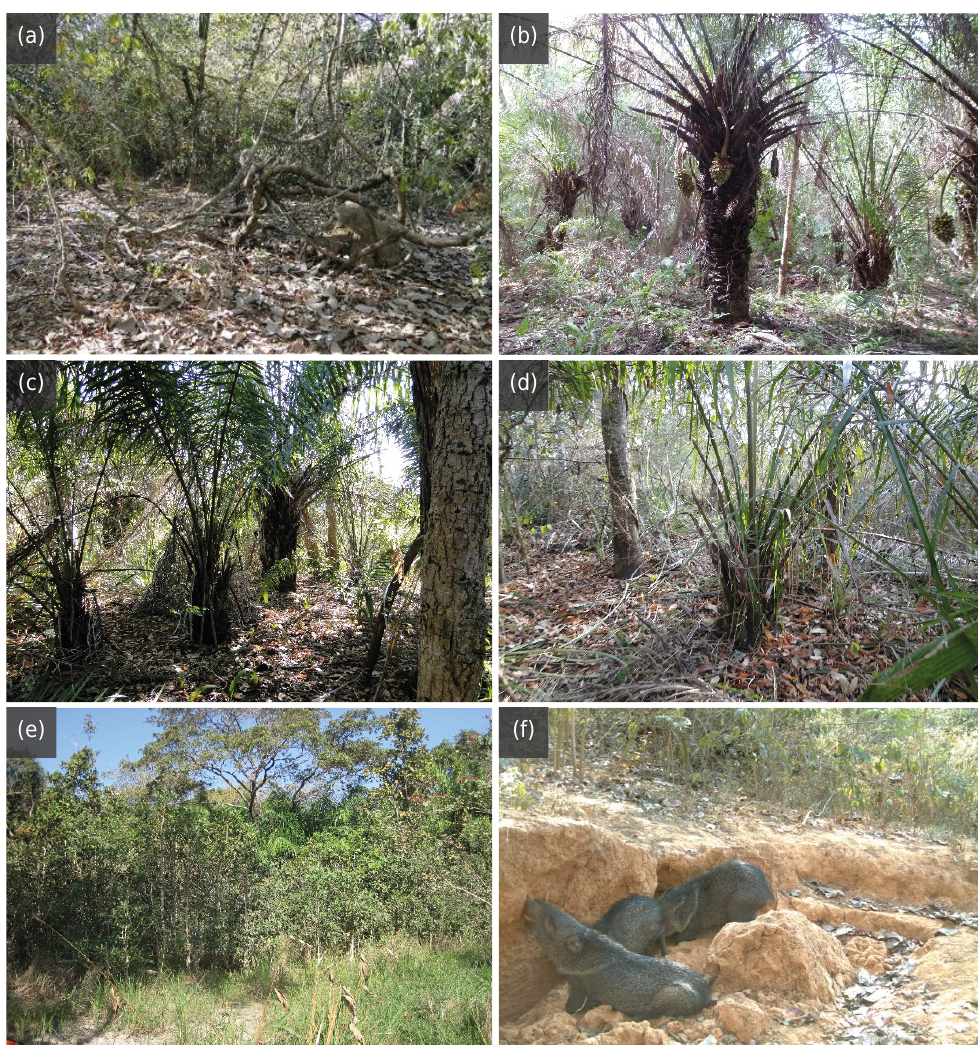
Figure 3. The areas where profiles P1(a); P2 (b); P3 (c); P4 (d); and P5 (e) were collected. The presence of Acuri ( Attalea phalerata ), an indicator plant for sodic soils, is observed in all locations. In P5, shrub/arboreal vegetation marks the sudden transition between the floodplain and higher lands. Geophagy of the sodic material is frequently observed (f) - image courtesy of Coelho